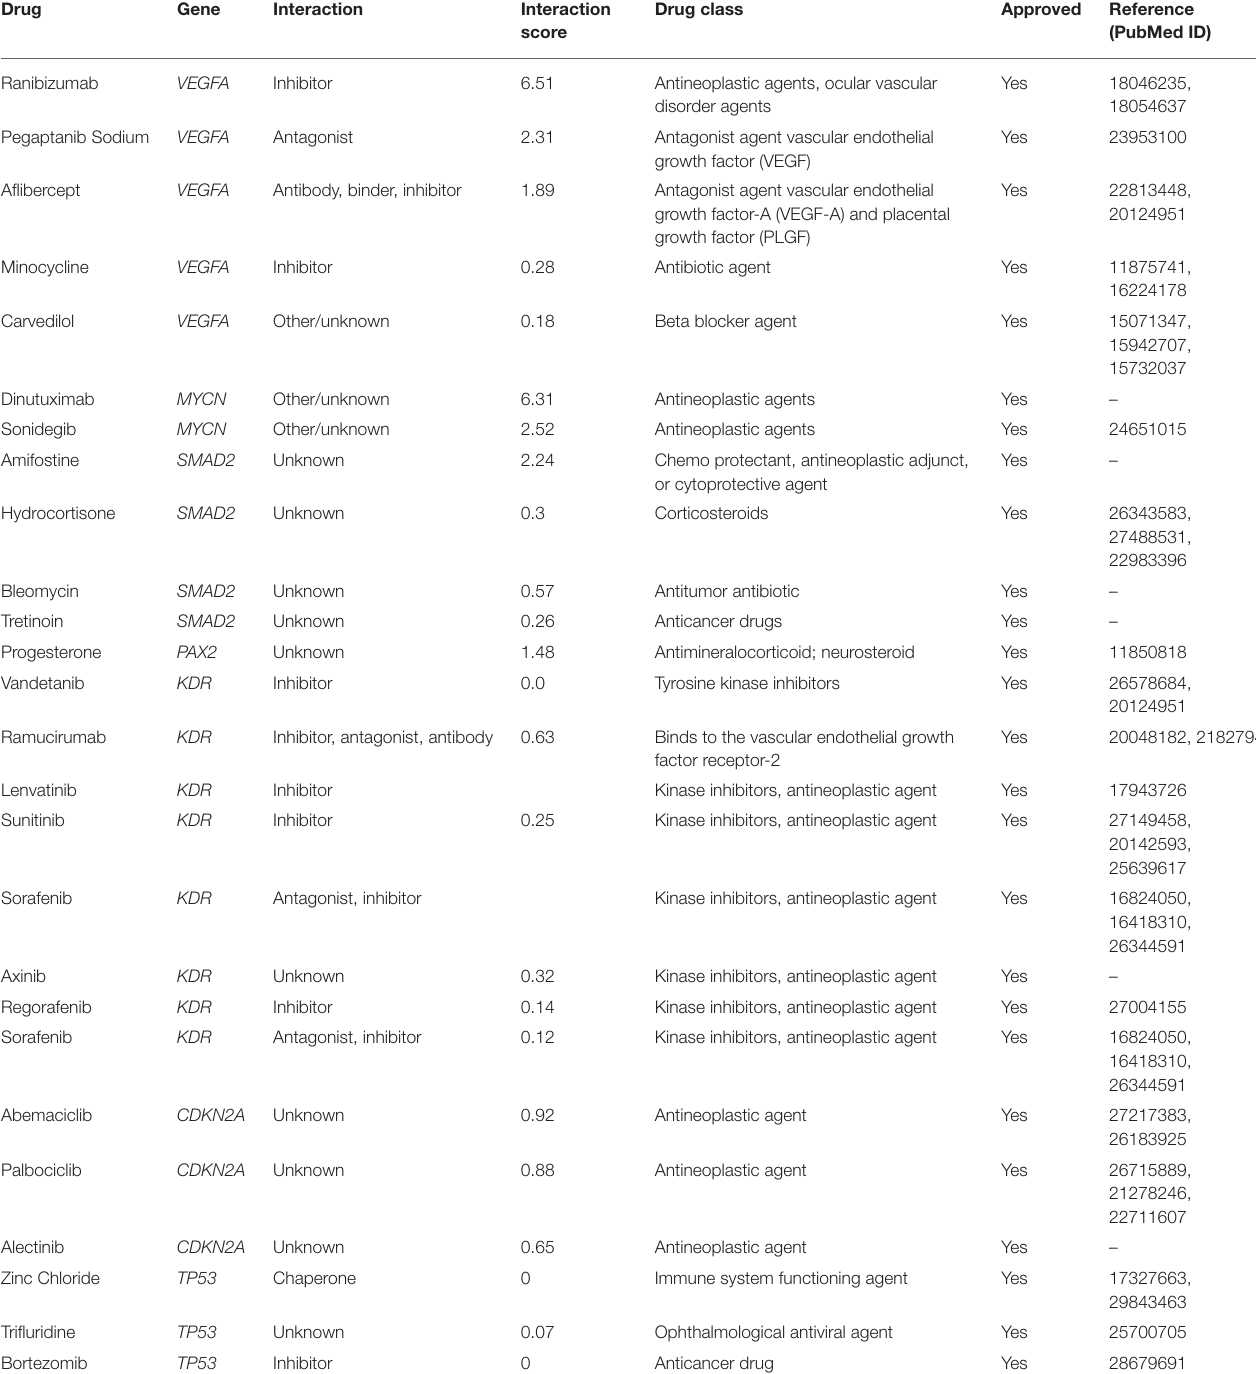
TABLE 4 | Details of the 26 Food and Drug Administration (FDA)-approved drugs that potentially target 7 of the 14 hub genes.